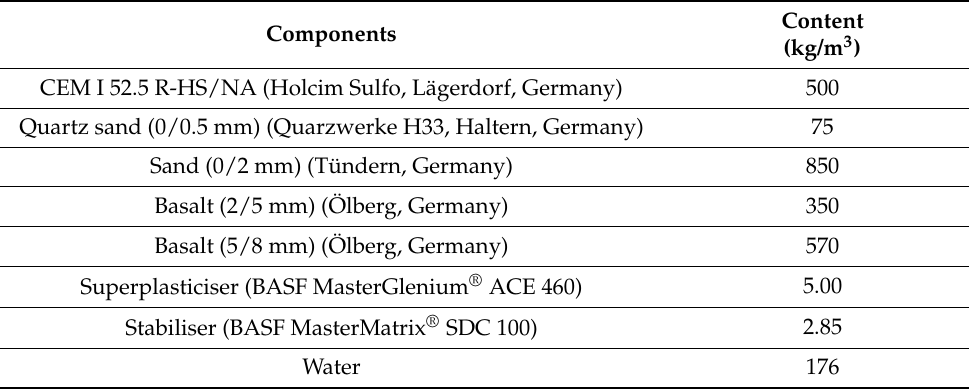
Table 1. Composition of the concrete RH1.